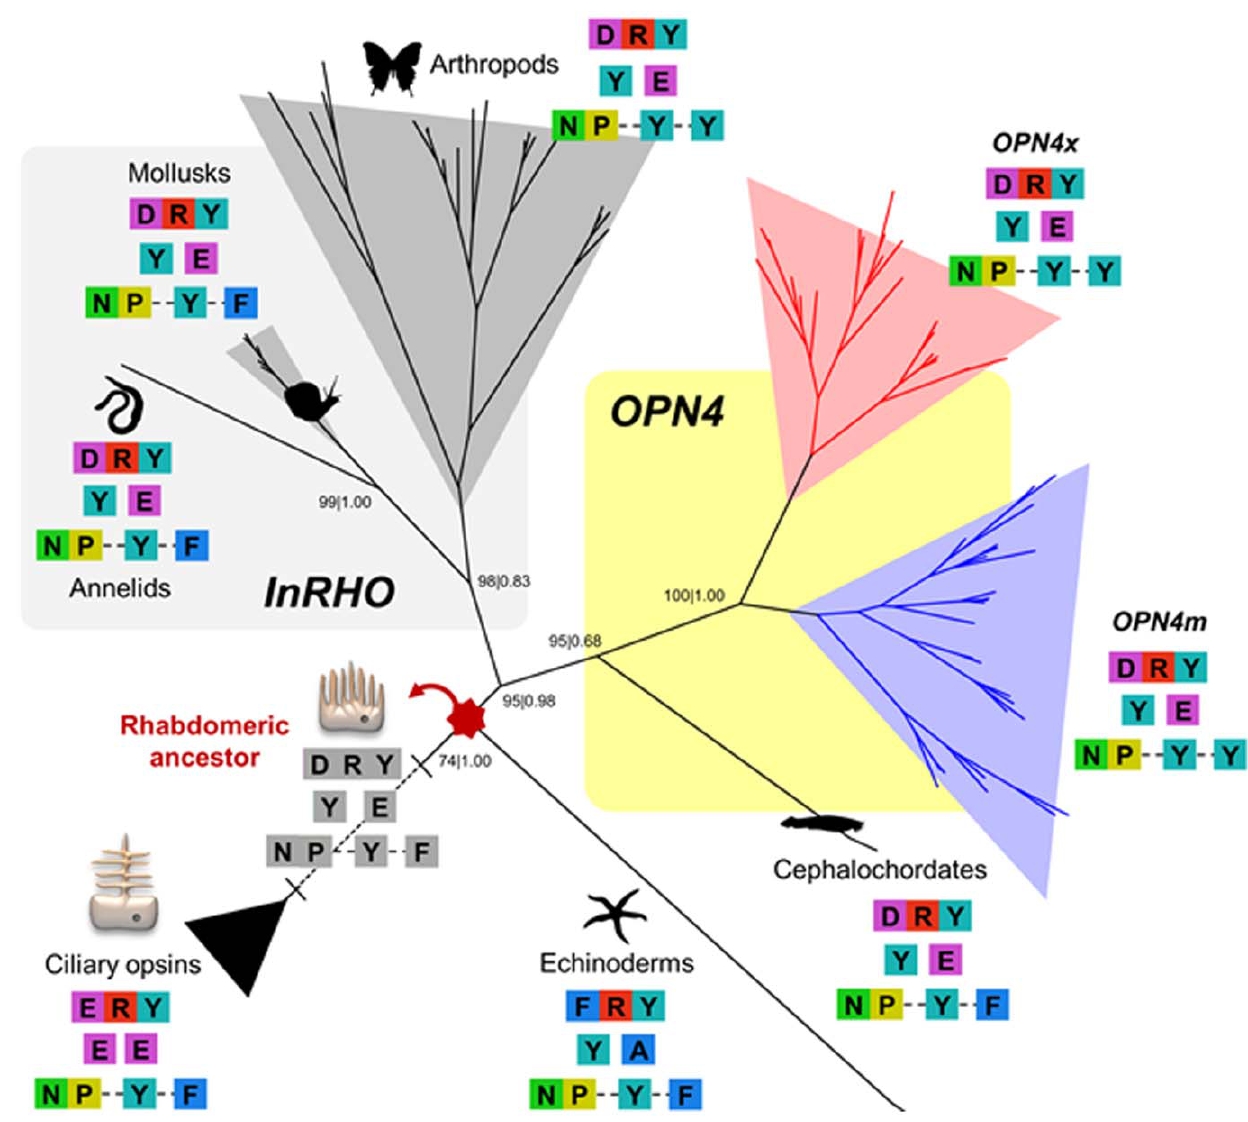
Figure 1. Phylogenetic depiction of the common-ancestry of invertebrate rhodopsins ( InRHO ) and melanopsin. The main opsin amino acid substitutions which are critical for the protein functional and structural innovations are color-coded. Maximum likelihood (ML) and Bayesian methods were used to build the phylogenetic tree and the support values of each method are shown for the main nodes (bootstrap and posterior probability, respectively). The grey amino acids are the maximum likelihood predicted motifs of the rhabdomeric photoreceptor ancestor.